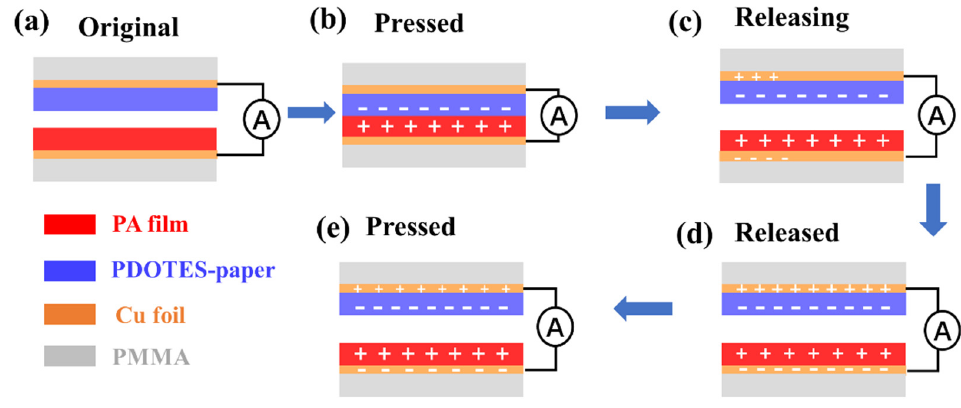
Figure 8. Structure and working principle of TENG. ( a ) PDOTES-paper-based TENG original structure; ( b )TENG friction layers are in contact with each other by external force; ( c ) Remove the external force to separate the TENG friction layer; ( d ) The TENG friction layer is separated to the maximum distance; ( e ) Cyclic pair reapplying external forces.